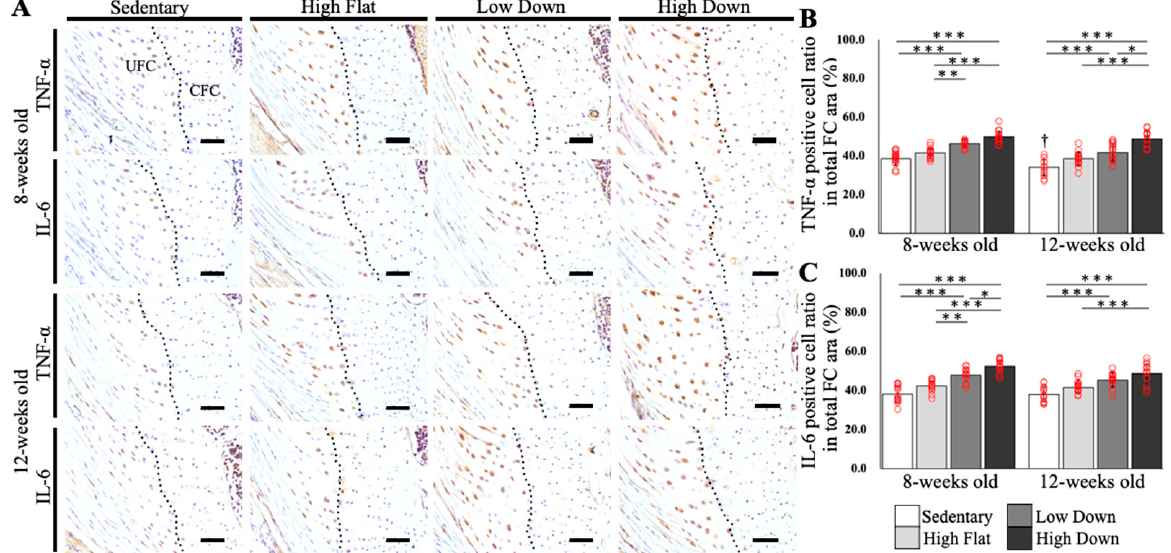
Figure 5. Comparison results of TNF- α and IL-6 expression in the enthesis fi brocartilage (FC) area. ( A ) IHC-stained tissue images of the enthesis FC areas according to week age. TNF- α and IL-6 are used as primary antibodies. The black dot line indicates the tidemark. ( B ) Comparison results of TNF- α expression in the FC area. ( C ) Comparison results of IL-6 expression in the FC area. Statistical signi fi cance: * p < 0.05, ** p < 0.01, *** p < 0.001. † p < 0.05 (8-week-old mice in the Sedentary group